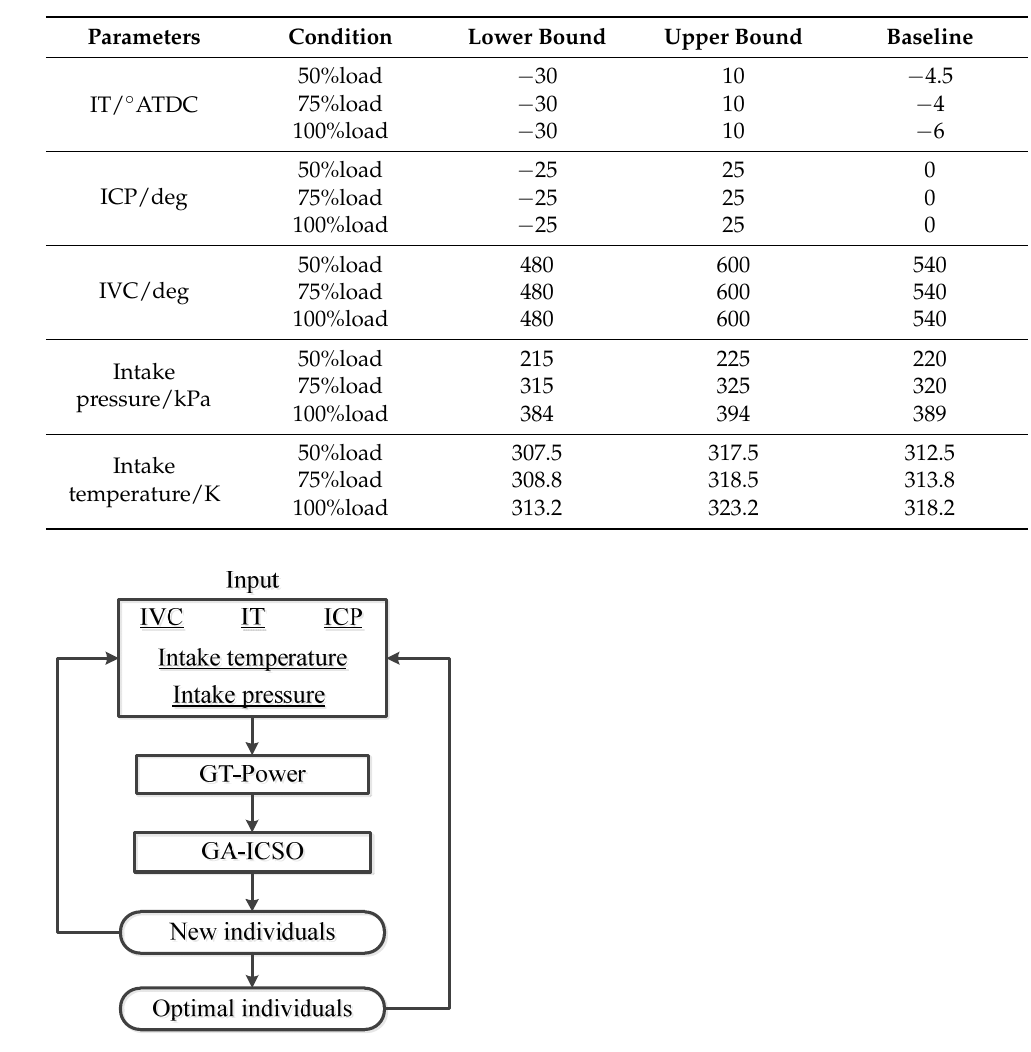
Table 5. Variation ranges in the design parameters.